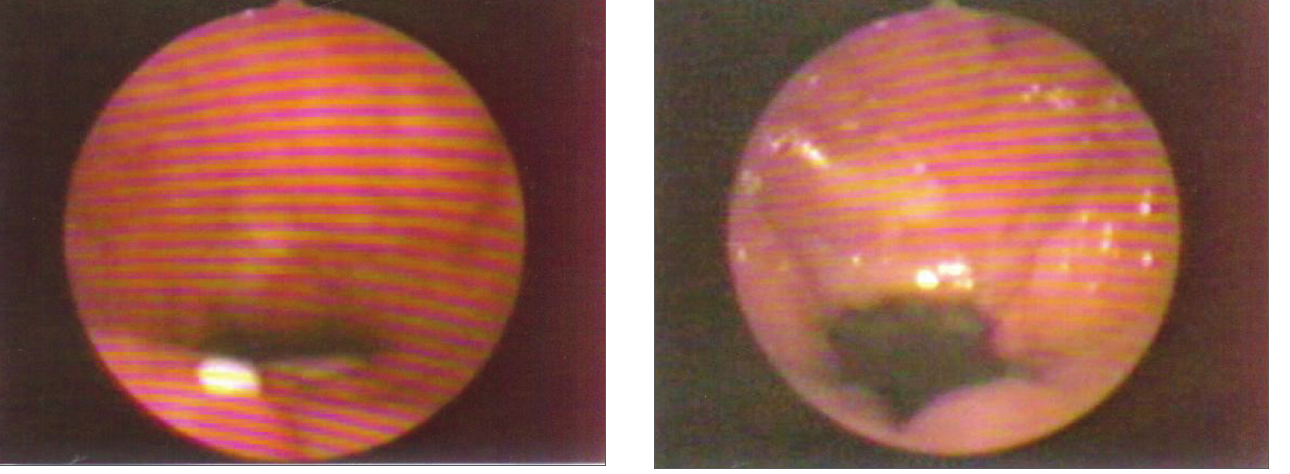
Figura 6. Paciente 3: fechamento do EVF em registro basal